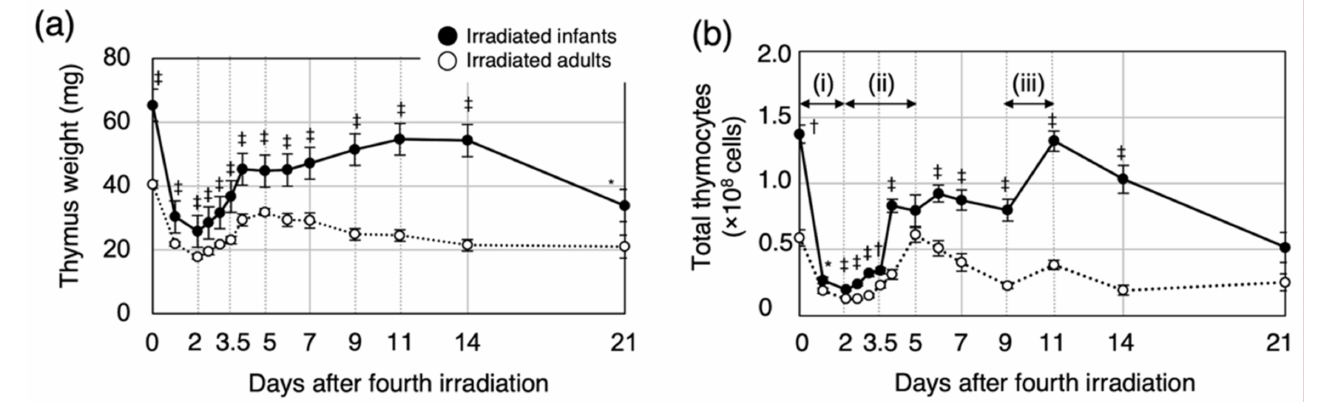
Figure 1. Change in thymus weight and cell number after whole-body irradiation of infant and adult mice. ( a ) Change in thymus weight of B6C3F1 mice after irradiation at infancy or adulthood. ( b ) Change in thymocyte number after the fourth irradiation. The recovery of thymocyte numbers was classified into three phases: reduction phase (i), first regeneration (ii), and second regeneration (iii). Six to fifteen mice were analyzed for each time point. Closed circles, average for irradiated infant mice; open circles, average for irradiated adult mice. * p < 0.05; † p < 0.01; ‡ p < 0.001, as compared with irradiated adult mice. Thymus weight and thymocyte counts in age-matched non-irradiated mice are shown in Figure